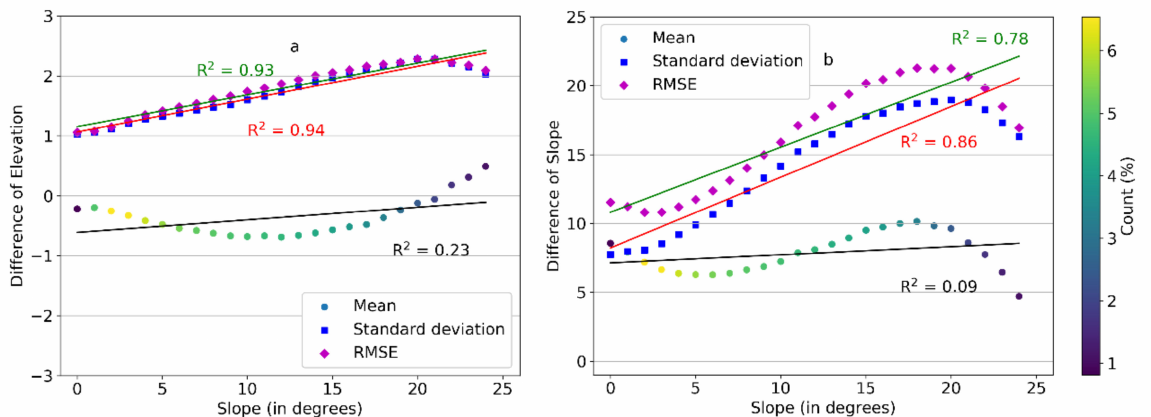
Figure 8. Relation between terrain slope and difference of elevation ( a ) and difference of slope ( b ). The mean value is represented using dots, whose color indicates the percentage of DTM points used to calculate the mean and standard deviation (see color bar on the right side). The lines represent the regression lines for the mean, the standard deviation and the RMSE.